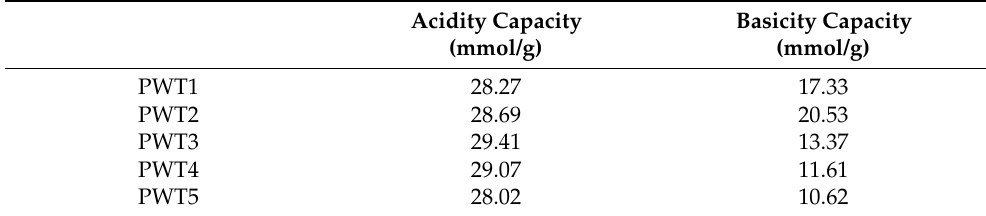
Figure 5. The temperature-programmed desorption of PWTx using ( a ) NH 3 and ( b ) CO 2 . Table 3. Acidity and basicity capacities calculated using NH 3 -TPD and CO 2 -TPD, respectively, for